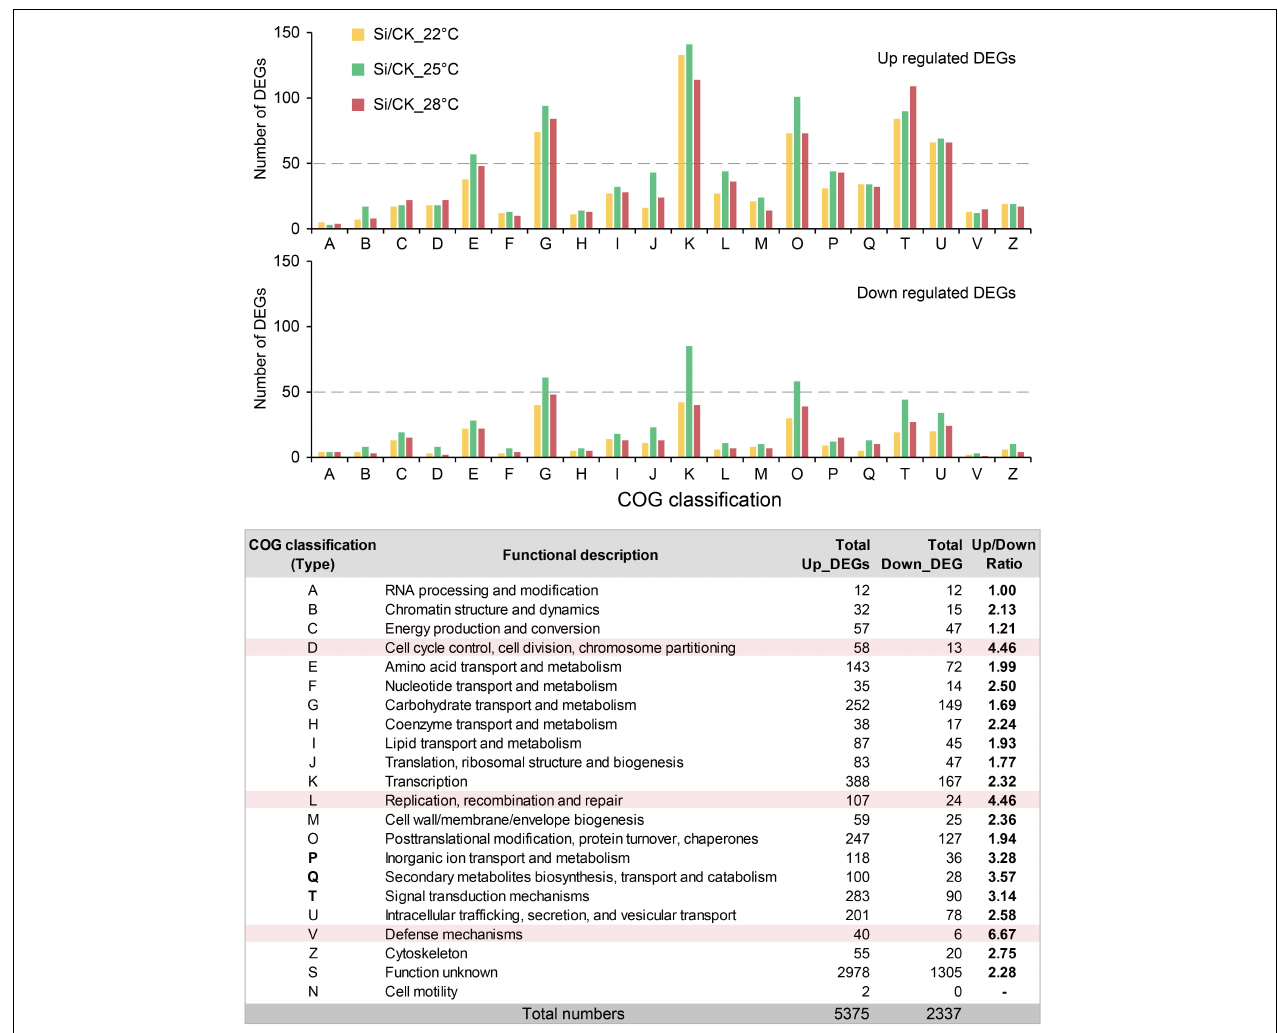
FIGURE 3 | Clusters of orthologous groups (COG) analysis of DEGs during S. indica colonization at different temperatures. COG of proteins analysis showed that there were more upregulated DEGs than downregulated DEGs in nearly each COG classification. The ratio of upregulated DEGs to downregulated DEGs was highest in the D, L, and V types, which were related to the cell cycle and division, DNA replication and defense response. The number of DEGs in the COG classification at each temperature is shown in Supplementary Table 2